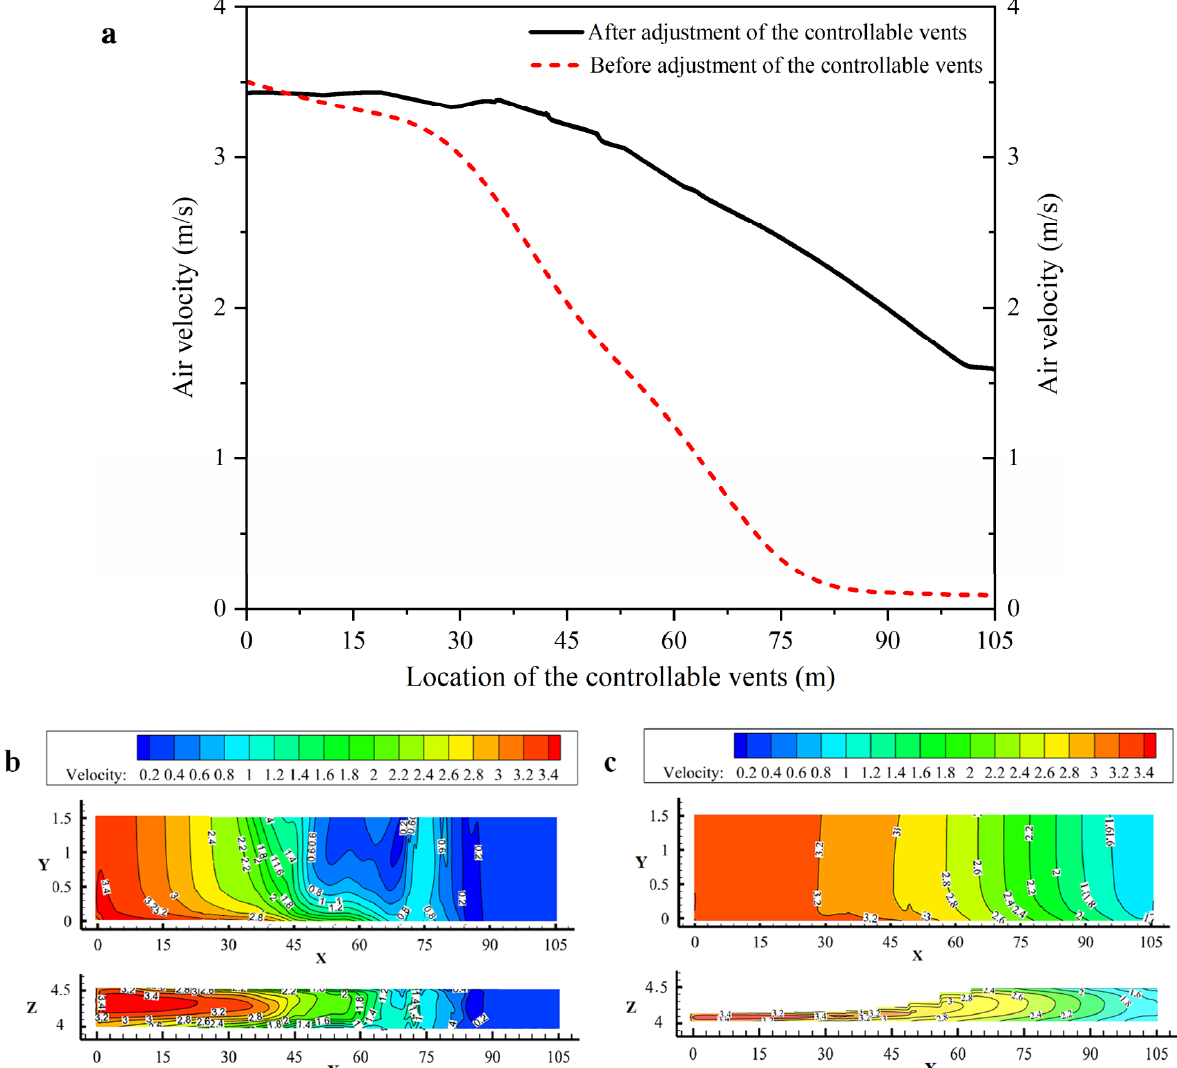
Figure 8. Air velocity distributions along the length of the platform: ( a ) Comparison of air velocity distribution before and after adjustment of the controllable vents. ( b ) Air velocity contour at the controllable vents before adjustment. ( c ) Air velocity contour at the controllable vents after adjustment.